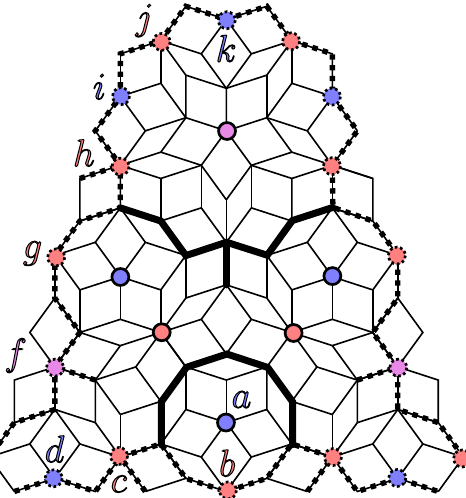
-vertices, and pink 5 - A B